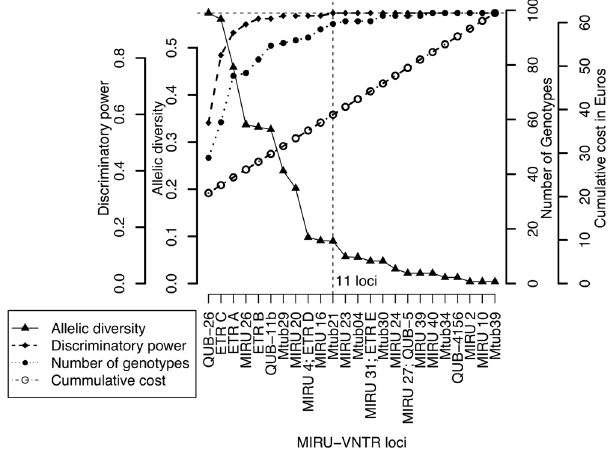
Figure 7. The optimization of cost and benefit (molecular discriminatory power) using number genotypes, discriminatory power, allelic diversity and cost of typing in Euros. The vertical dotted line represents the optimum point at which is the least cost for which one can obtain the highest discriminatory power and number of genotypes. This optimum point is reached with 11 MIRU-VNTR loci used with spoligotyping. This is multi scale two sided Y axis graph, the outer and inner left scales represent the discriminatory power and Allelic diversity respectively while the outer and inner right scales represent the cumulative cost and number of genotypes respectively. The base-line cost of typing is €20 which represents the cost of running only Spoligotyping per sample. The cost increment there after is the cost of adding a MIRU-VNTR